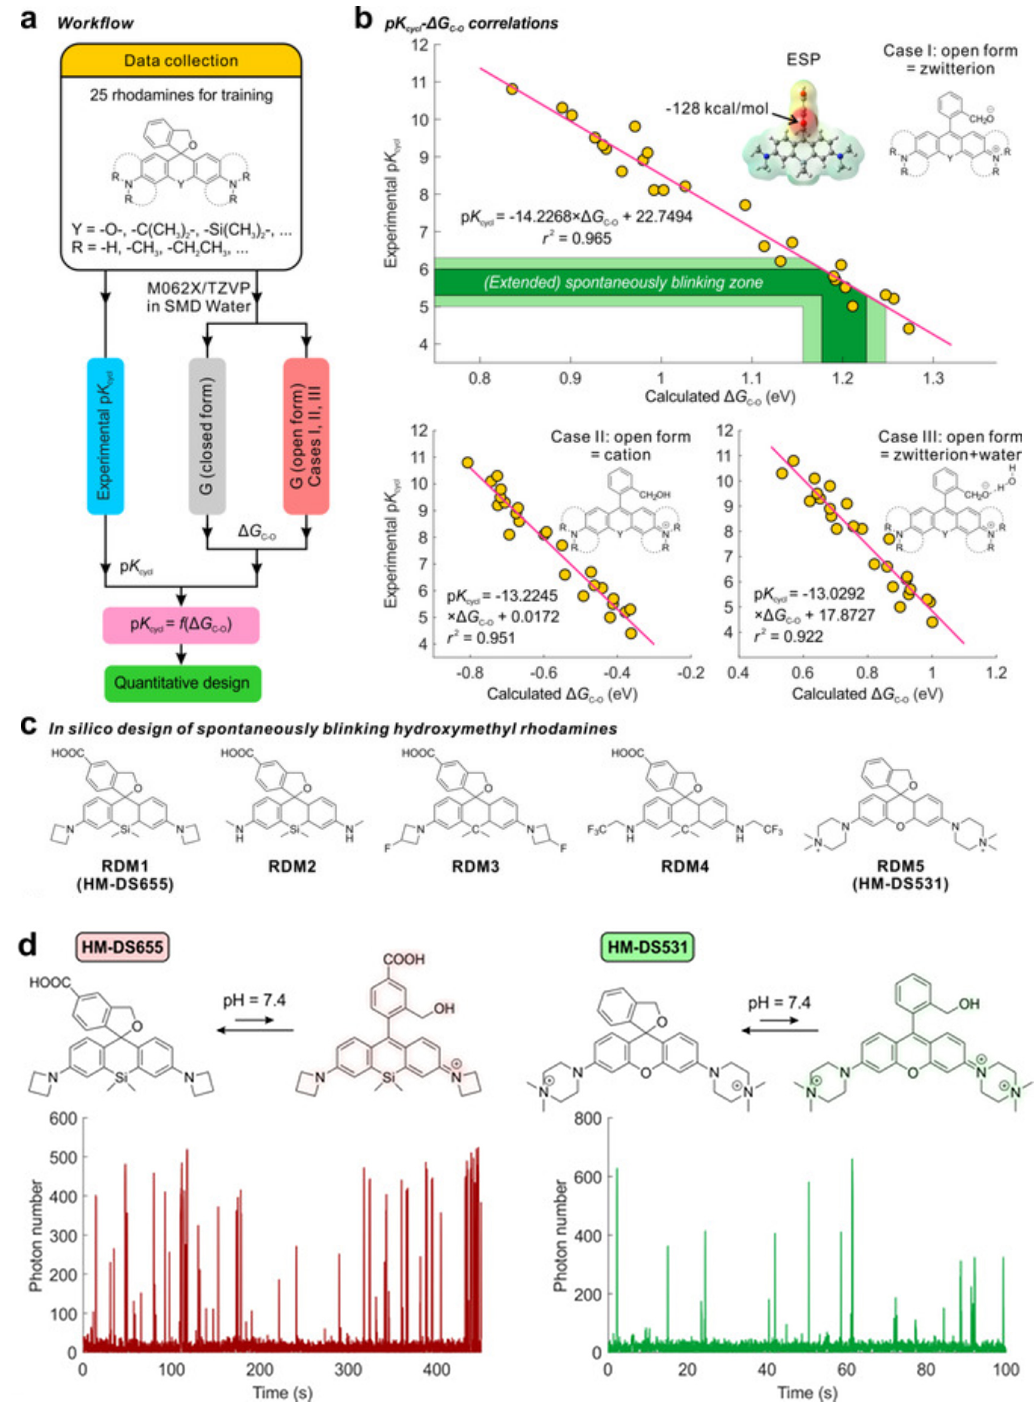
Figure 31. Computational approach to predict the pK cycl value of blinking dyes: ( a ) The workflow in this work; ( b ) Correlations between calculated Δ G C-O and experimental pK cycl values for a series of hydroxymethyl rhodamine dyes reported by our group; three types of open forms were considered: zwitterion, cation, and zwitterion + water; ( c ) Molecular structures of computationally designed spontaneously blinking rhodamines RDM1-RDM5 with synthesized candidates HM-DS655 and HM-DS531 ; ( d ) blinking of HM-DS655 and HM-DS531. Adapted with permission from [302].